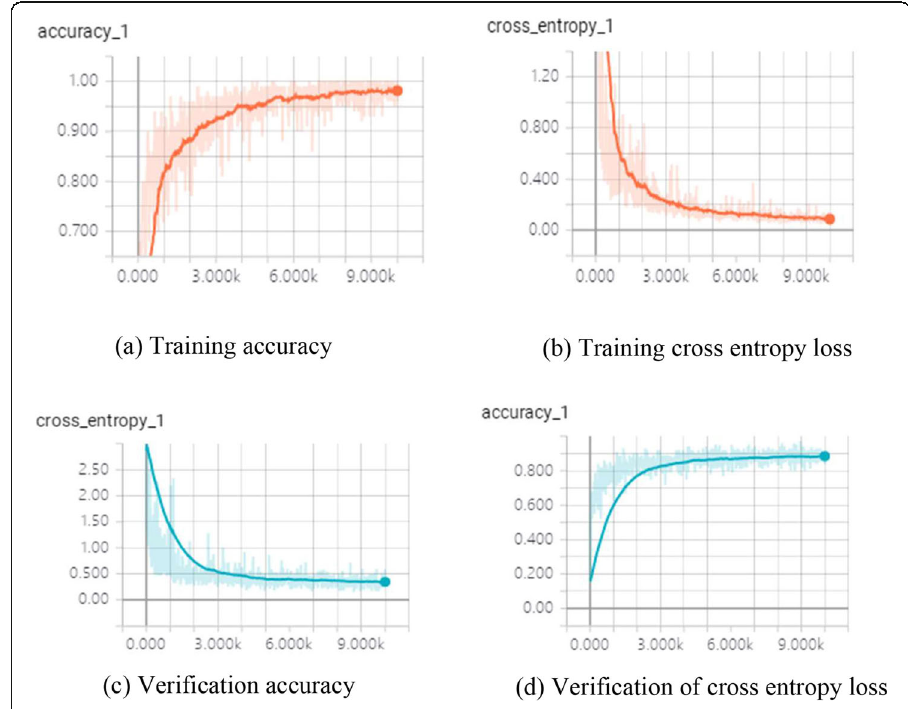
Fig. 6 Results of the accuracy and cross-entropy loss during training and verification. a Accuracy during training. b Cross-entropy loss during training. c Accuracy during verification. d Cross-entropy loss during